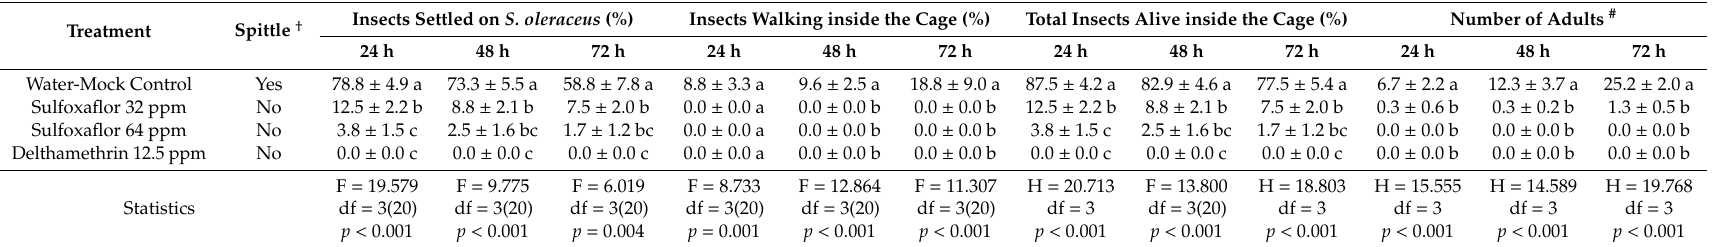
Spittle formation after 72 h of insecticide treatment, # adults molted during the time lapse of the experiment from the L4 nymphs released at the beginning of